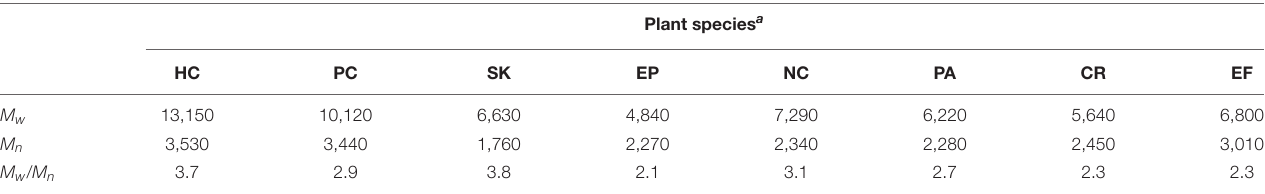
TABLE 1 | Weight-average (M w ) and number-average (M n ) molecular weights (g mol − 1 ), and polydispersity (M w /M n ) of the lignin-like fractions isolated from ancestral